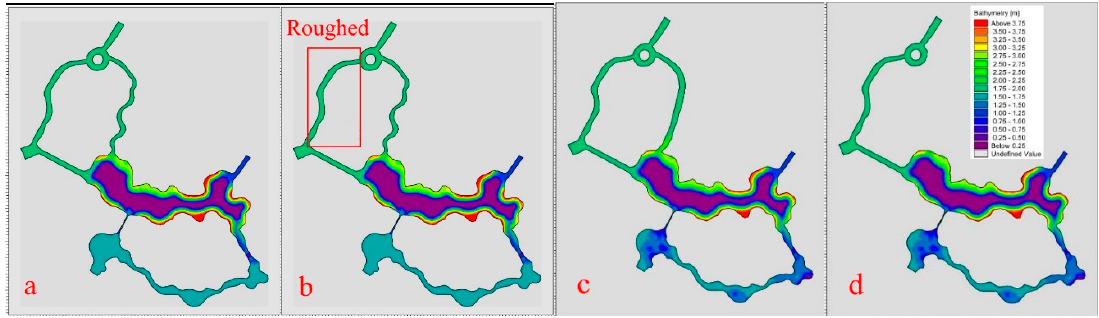
Figure 9. The river layout program. ( a ) Original Planning river; ( b ) “Roughed” river; ( c ) “Bilateral” rivers; ( d ) “Unilateral” river.